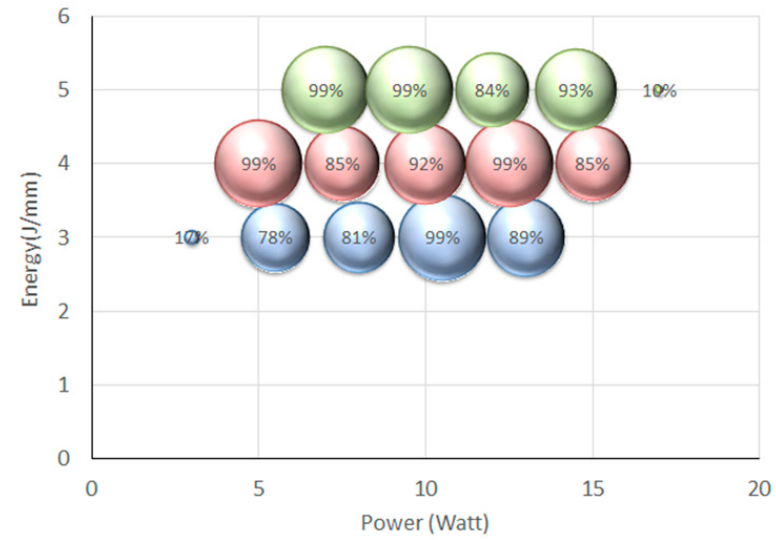
Figure 10. Stochastic prediction of weld quality by the developed Deep